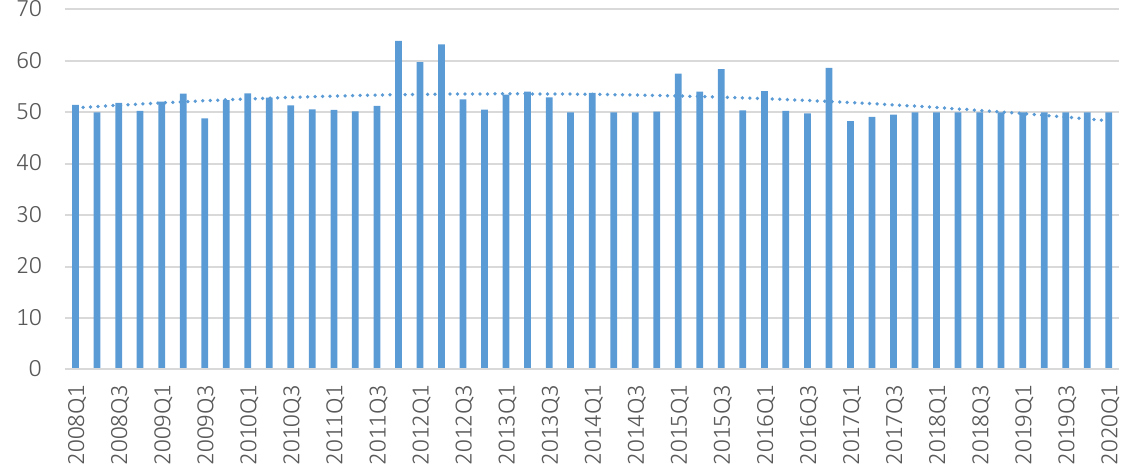
Figure 3. Dynamics of the integrated index of Ukraine’s banking system stability and the polynomial trend calculated by the Mamdani fuzzy logic